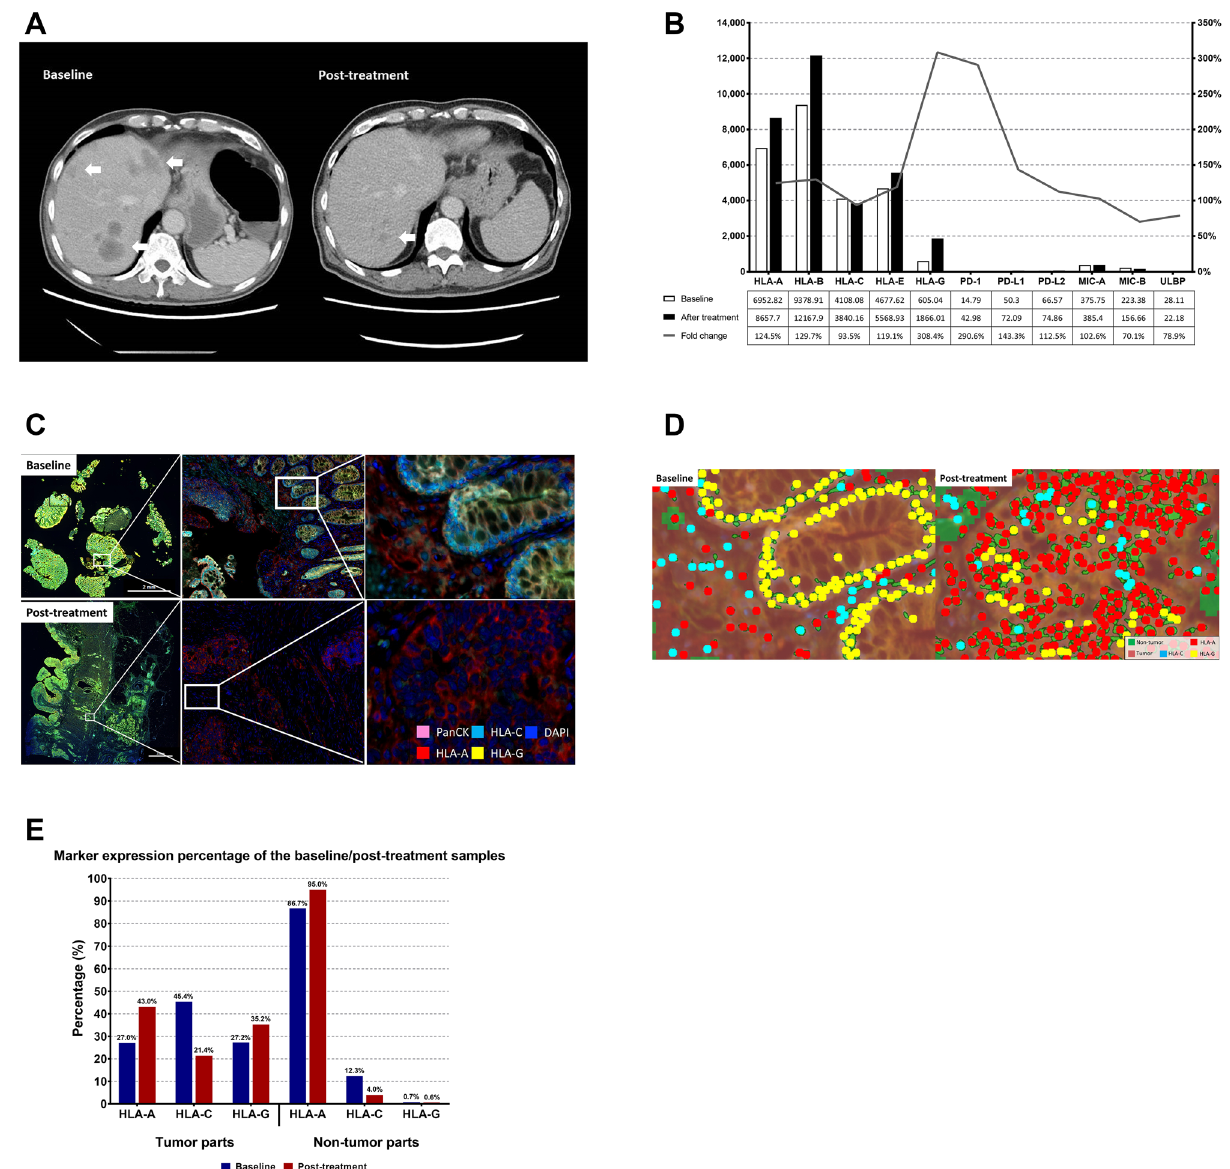
Figure 6. ( A ) CT scan of liver metastases from the patient before (baseline) and after (post-treatment) systemic targeted therapy and chemotherapy. Arrows indicate locations of liver metastases. ( B ) Counts for mRNA of MHC class I, NK cell ligands, PD-1, PD-L1, and PD-L2 from tumors at baseline (white bar) and after treatment (black bar) by NanoString. Grey line indicates the fold change shown as percentage. ( C ) IHC staining from the tumor tissue before (baseline) and after (post-treatment) systemic targeted therapy and chemotherapy. DAPI staining indicated the nucleus. Pan-CK staining indicated tumor cells. All immunofluorescence signals were within one image. ( D ) Computerized scanning of IHC staining from the tumor tissue before (baseline) and after (post-treatment) systemic targeted therapy and chemotherapy. The tumor parts were defined as pan-CK positive and DAPI-positive cells. The nontumor parts were defined as pan-CK negative and DAPI-positive cells. The whole field was then counted with a computer. ( E ) Percentage of marker expression for MHC class I, from tumor at baseline (blue bar) and after treatment (red